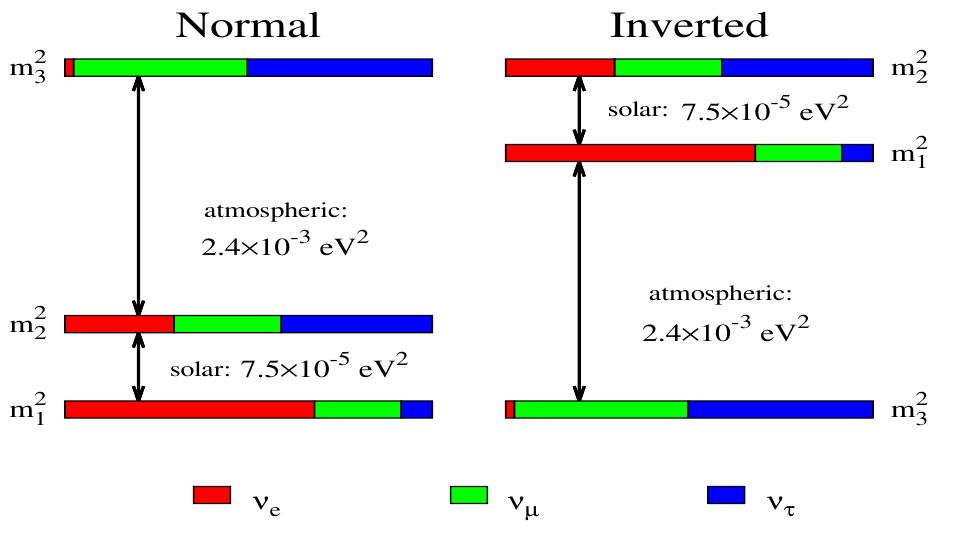
Figure 2. The two possible schemes for the neutrino mass eigenvalues: on the left the normal ordering (or normal hierarchy), with (or inverted hierarchy), with differences are not represented in scale, but, in any case, one can appreciate the gap existing between the “solar” and the “atmospheric” ones. The different colors represent the flavor compositions of all the three neutrino mass